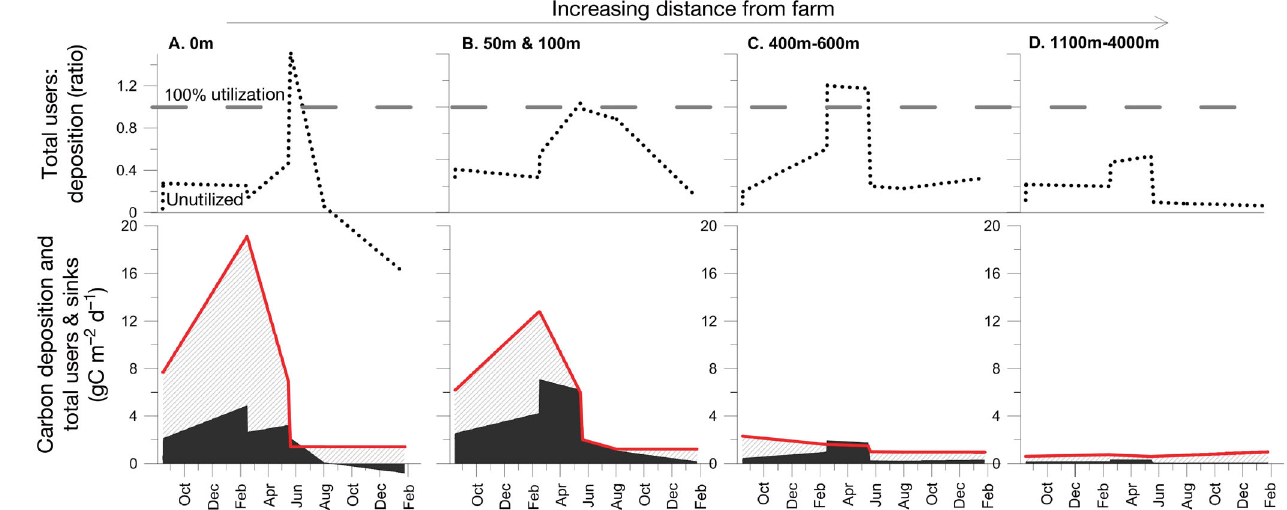
Fig. 9. Sum of total measured carbon consumption, use and accumulation (black area = burial + somatic growth + macrofaunal respiration + microbial oxidation) in relation to deposition flux (inputs, red line) through the production cycle at 4 distances along the main transect: 0 m stations (A1−A4; stations 0m-A and 0m-B averaged), 50 and 100 m stations (B1−B4; averaged), 400 and 600 m stations (C1−C4; averaged), 1100−4000 m stations (D1−D4;